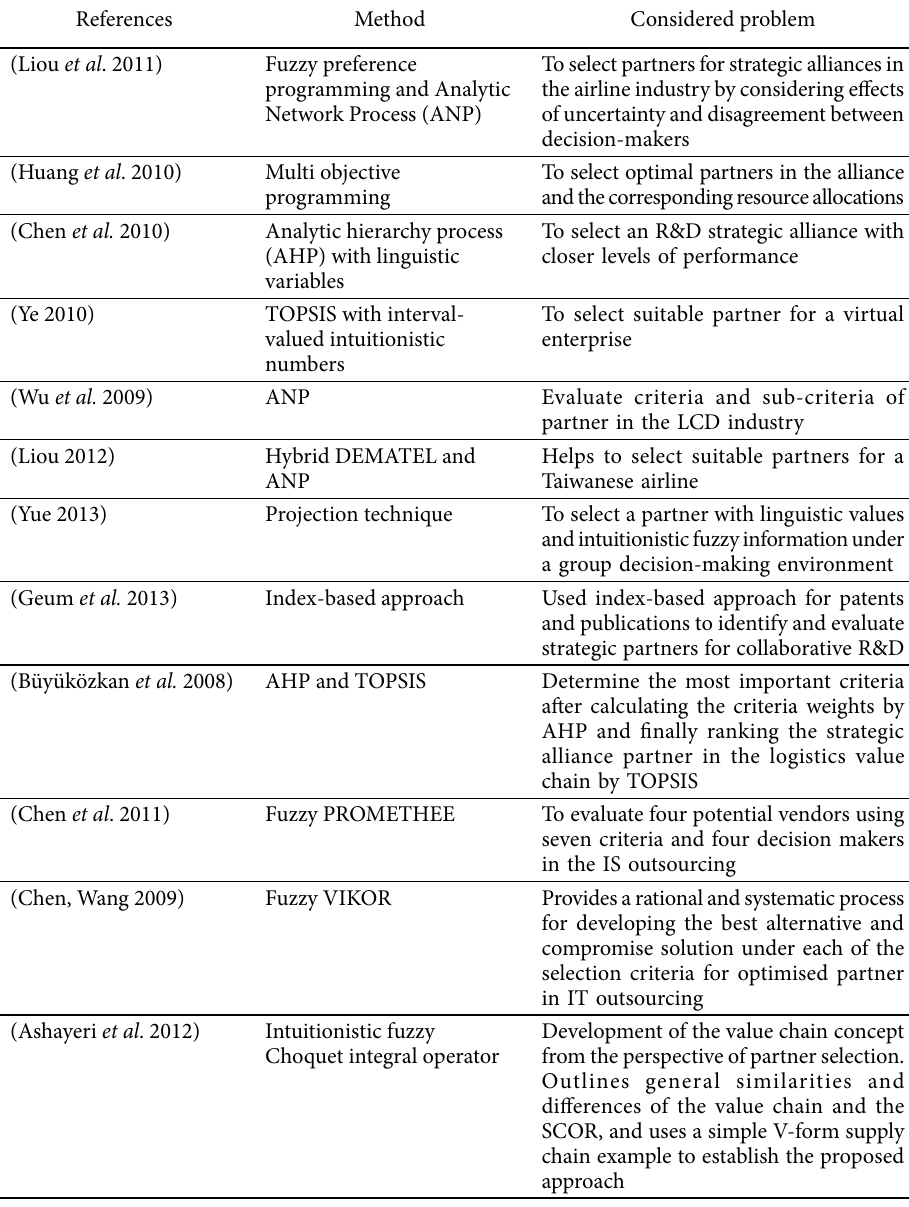
Table 1. Partner selection